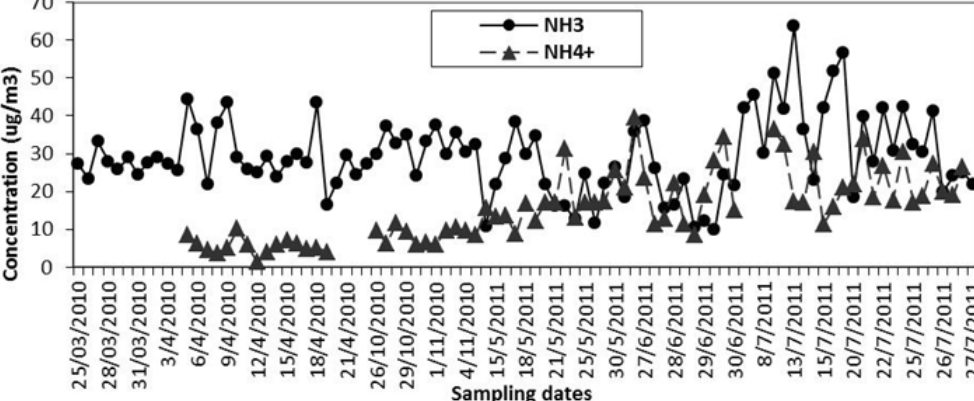
Fig. 5a. Full time series with all the day measurements for both NH 3 and NH +